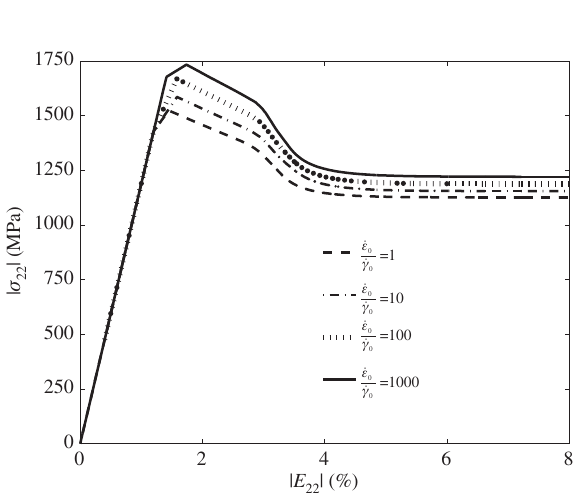
Figure 11 Sample S , rate-dependent behavior: average stress 1 component | σ | over applied strain | E 22 for different